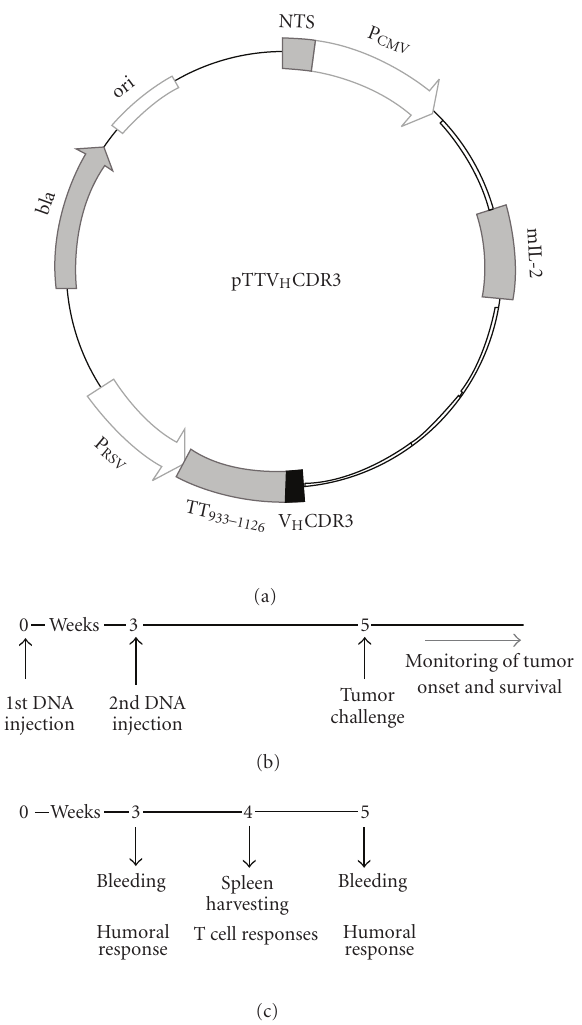
Figure 1: DNA fusion vaccine schematic structure (a). Experimen- tal design of protective (b) and immune responses (c) studies is showed. C3H/HeN mice were immunized twice at 3-week intervals by intramuscular injection followed by electroporation. Unim- munized (na¨ıve) mice received a mock vaccination by injection with phosphate saline bu ff er. Two weeks after boosting mice were injected i.p. with 2 × 10 2 38C13 cells.